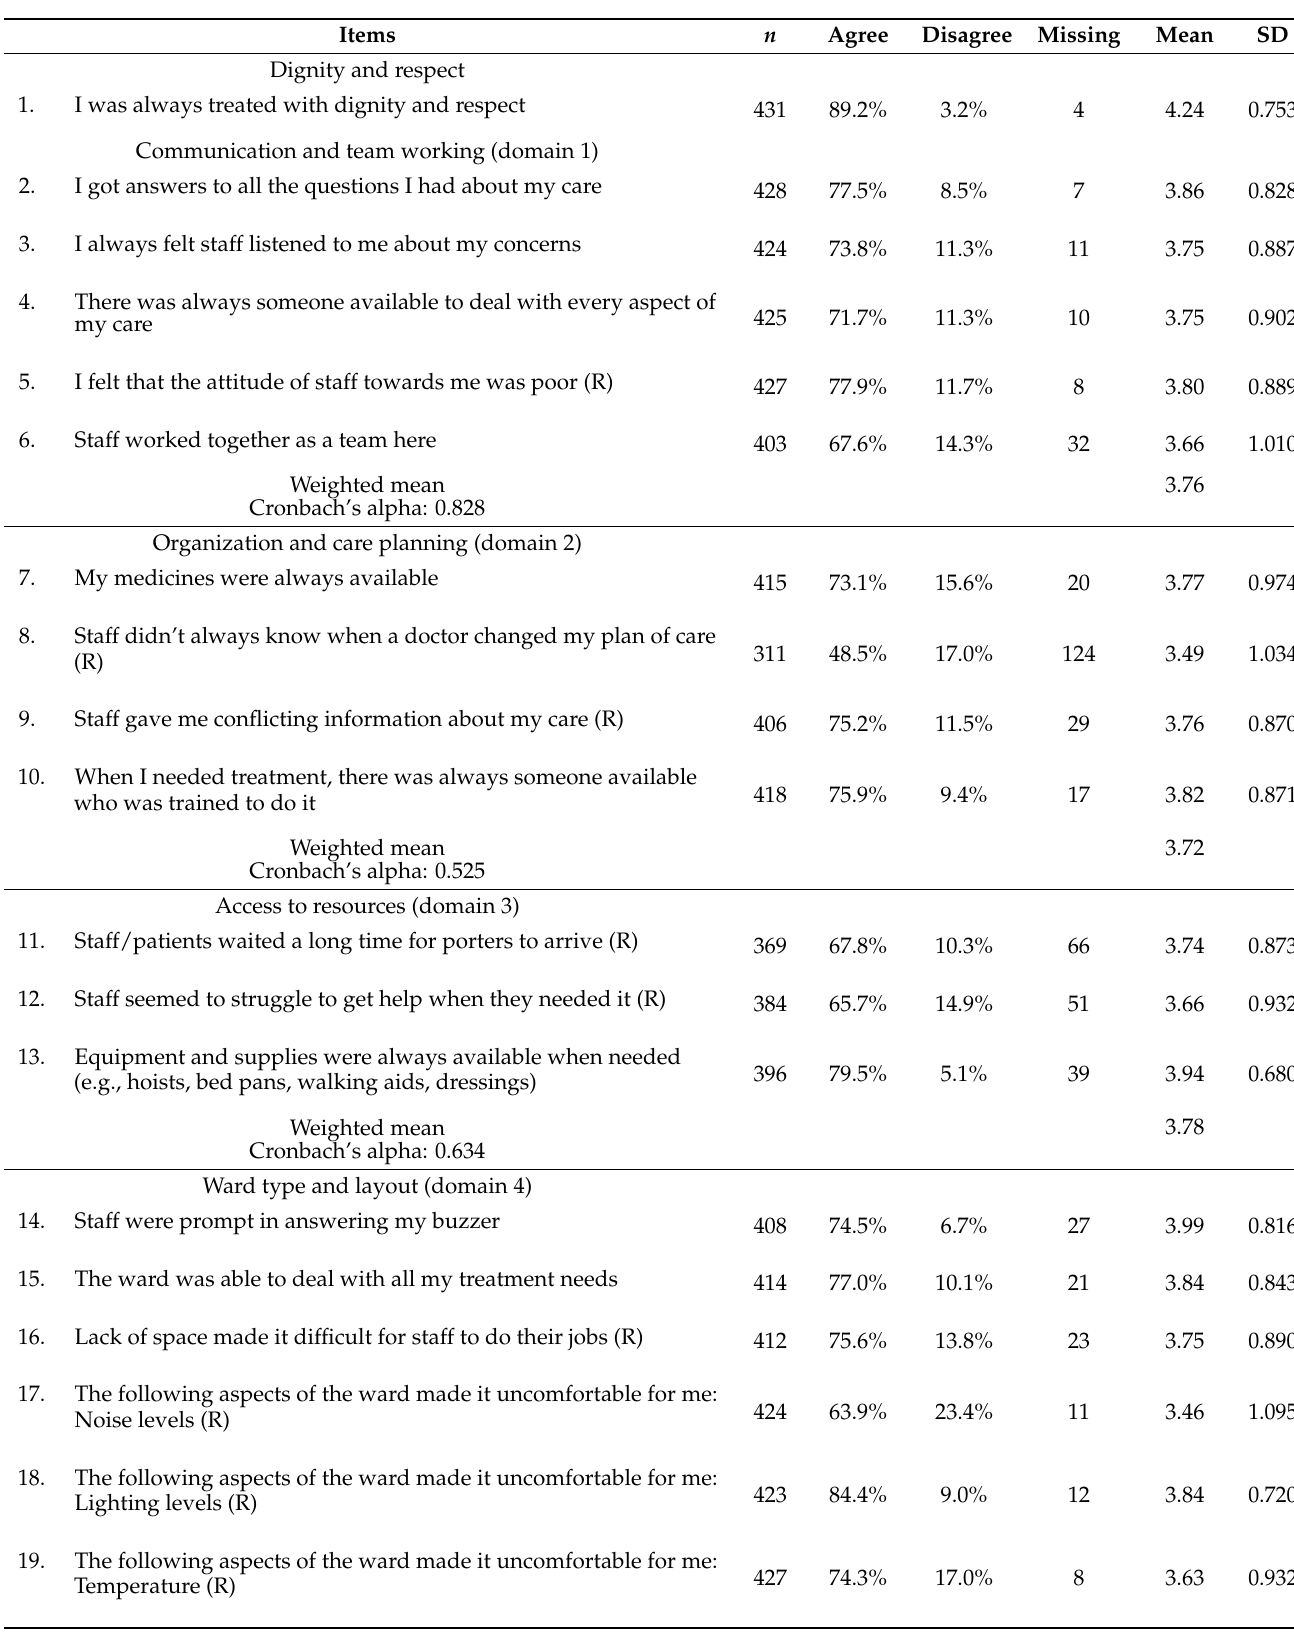
Table 2. Patients’ perception of safety with PMOS-30